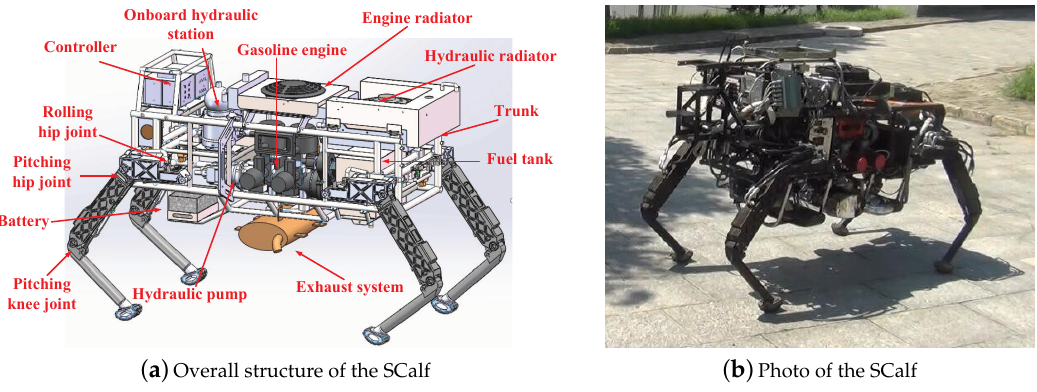
Figure 1. The hydraulic actuated quadruped robot